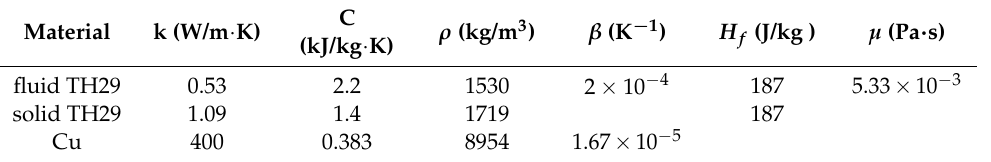
Table 5. Material thermo-physical properties [2].